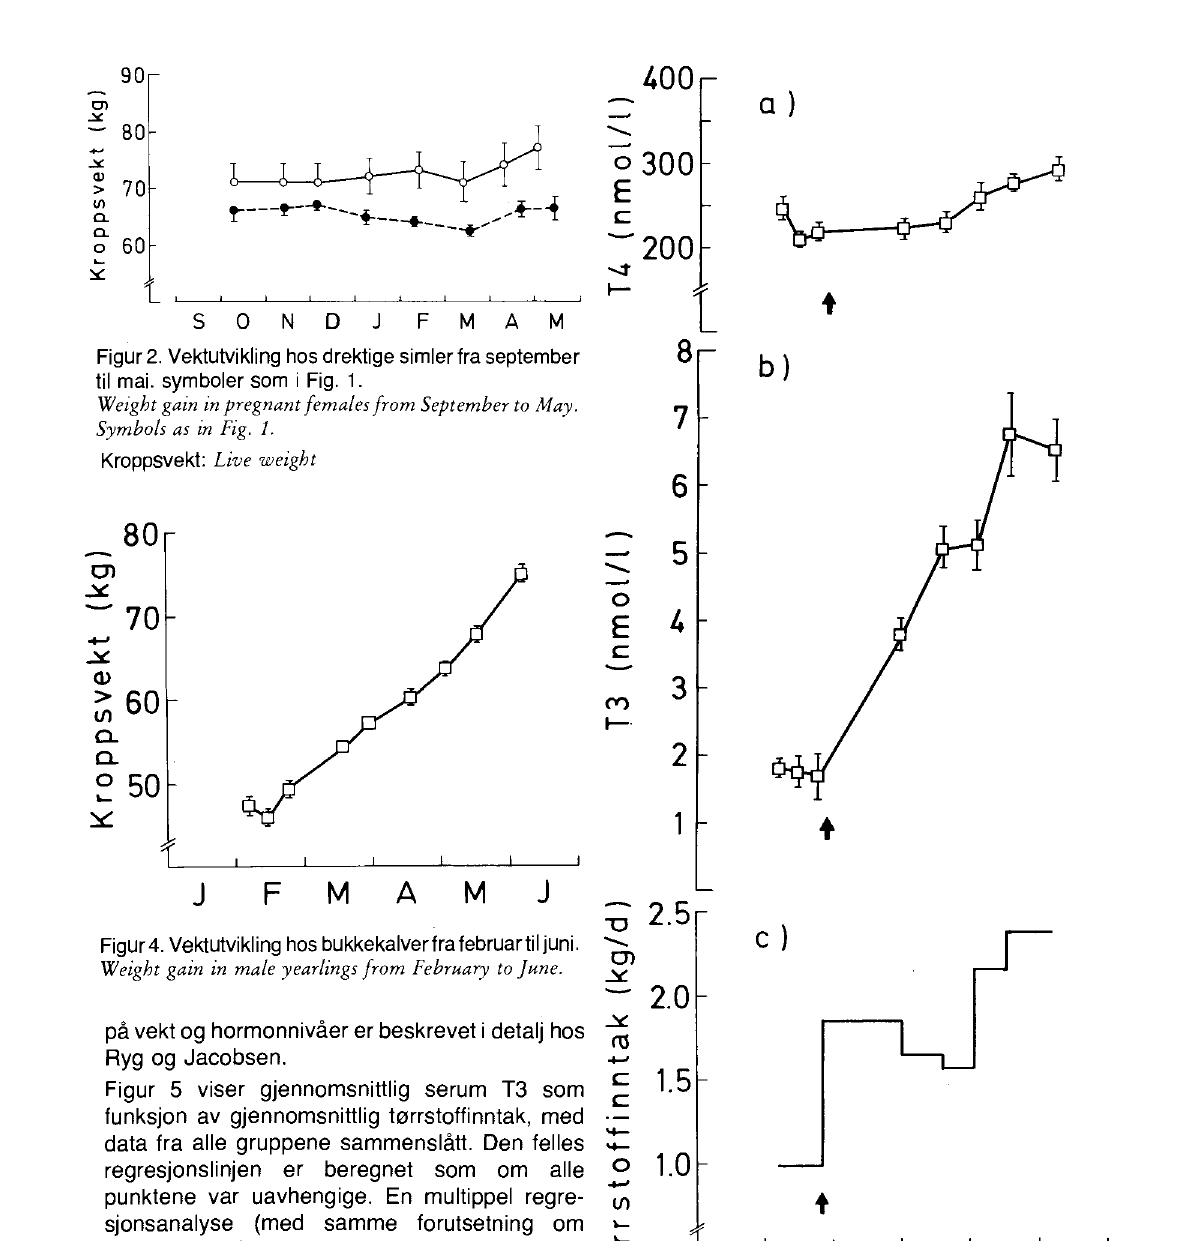
Figur 3. Hormonnivåer sammenholdt med næringsinn tak hos bukkekalver fra februar til juni. Pilen markerer overgang fra begrenset til ad lib.